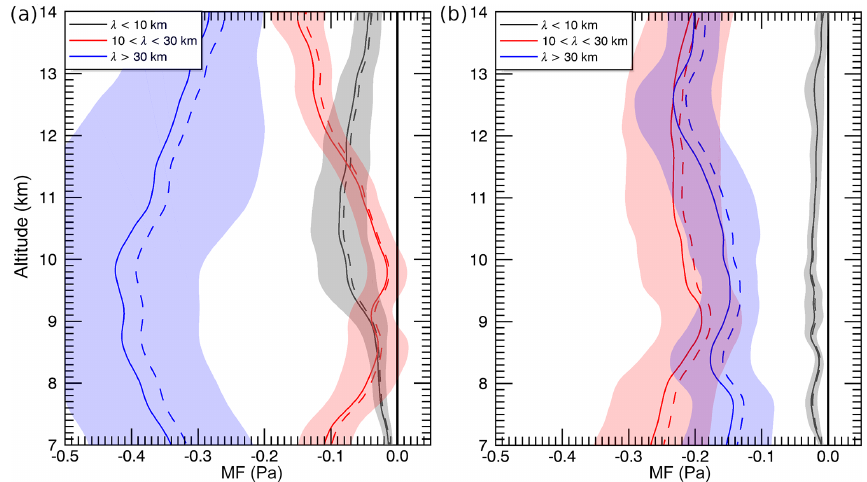
Figure 16. Averaged momentum fluxes for (a) run 5 (no TIL) and (b) run 6 (TIL) as mean for varying leg length (solid) with standard deviation (shading) and for the full leg distance [ − 300, 400km] (dashed). Three wave classes are colour coded and the bold black line separates positive and negative